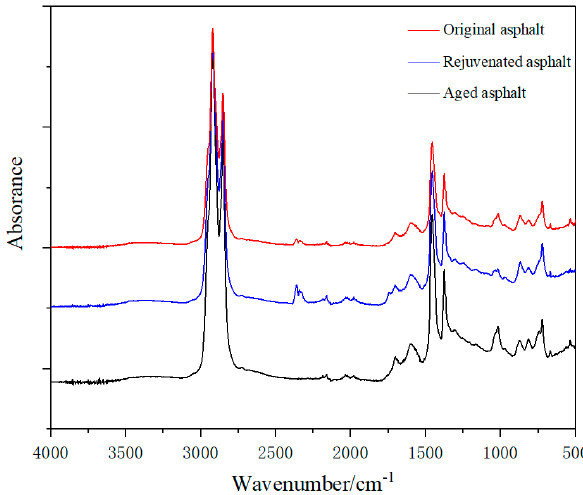
Figure 10. FTIR spectra results of VA, aged asphalt, and rejuvenated asphalt.